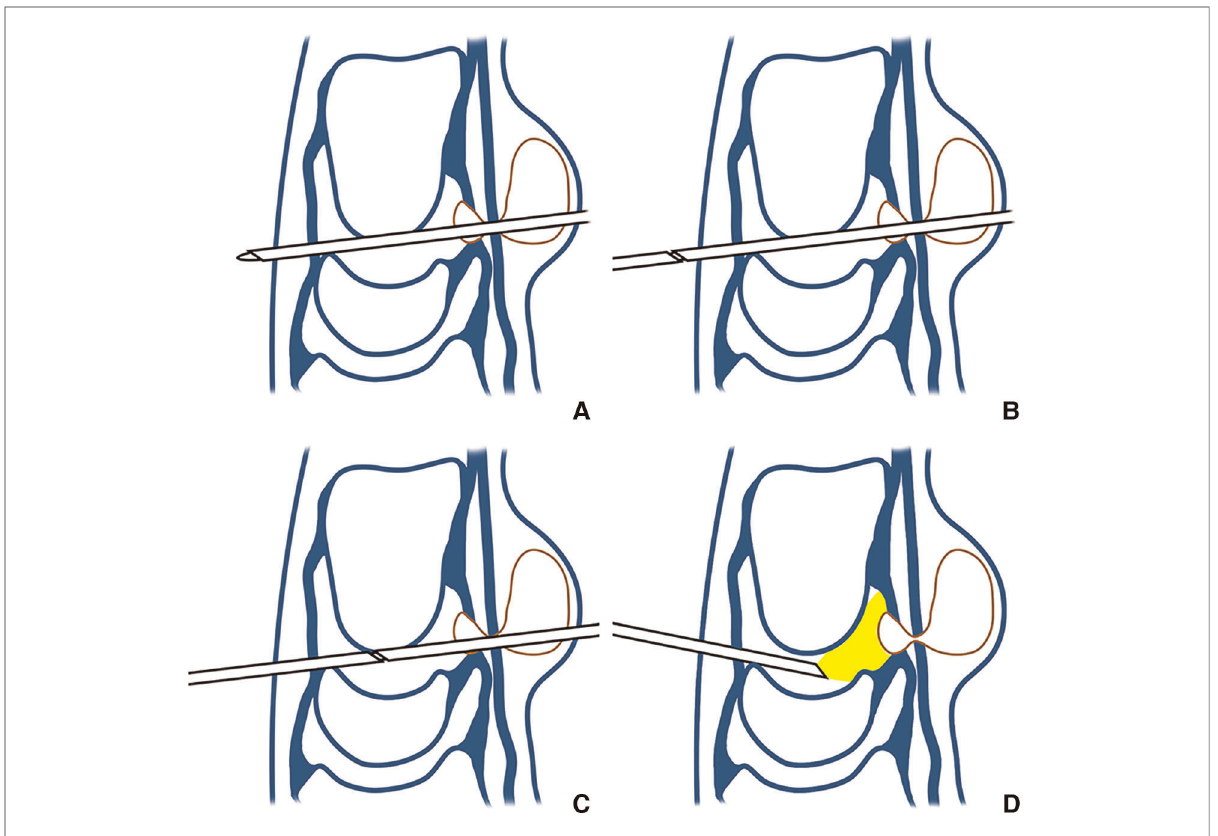
FIGURE 2 ( A - D ) Kiss-in method ’ s sketches for each stage of Figure 1 ( A - D ) in